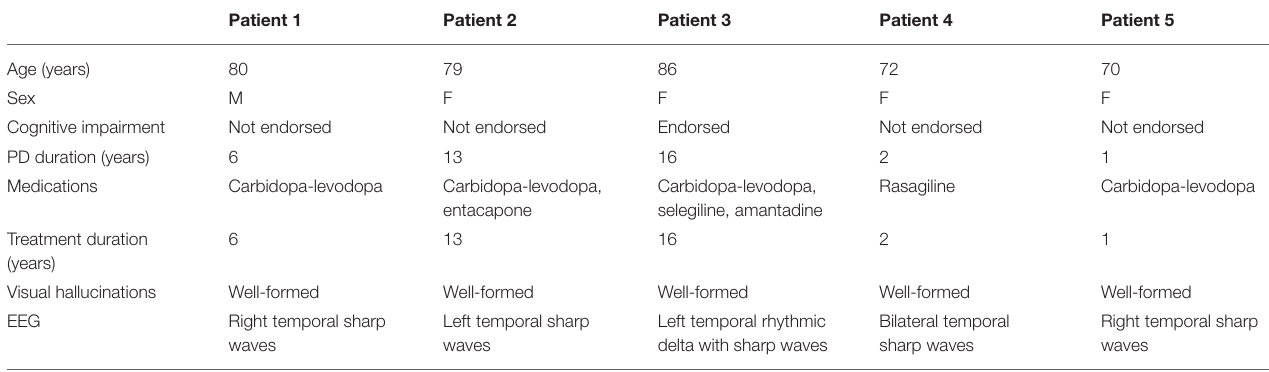
TABLE 1 | Characteristics of patients with epileptiform discharges on routine EEG.